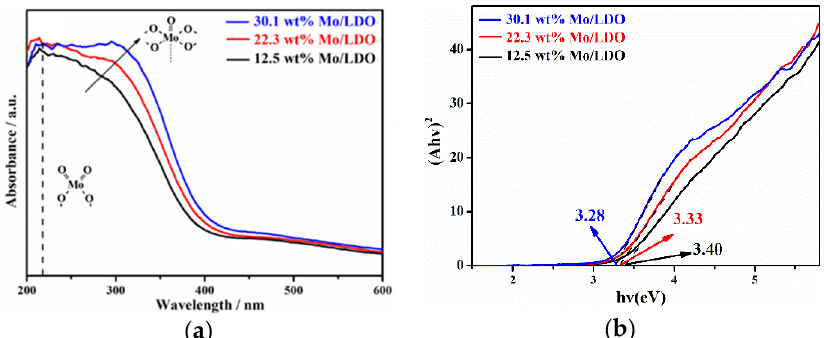
Figure 5. ( a ) UV–vis diffuse reflectance spectra of Mo/LDO catalysts and ( b ) Kubelka–Munk plots of the samples.